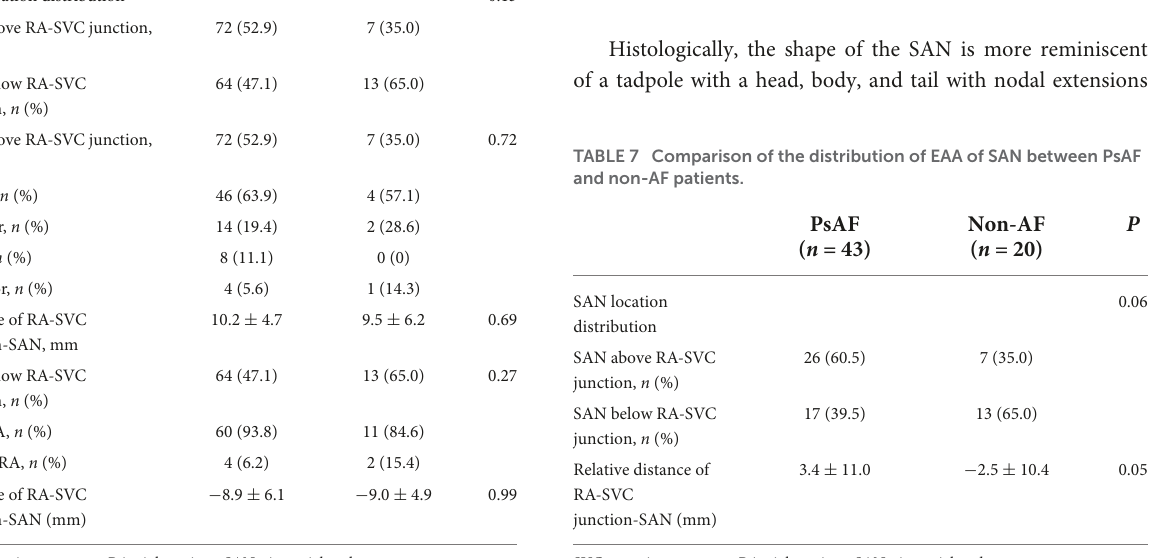
All patients ( n = 136)